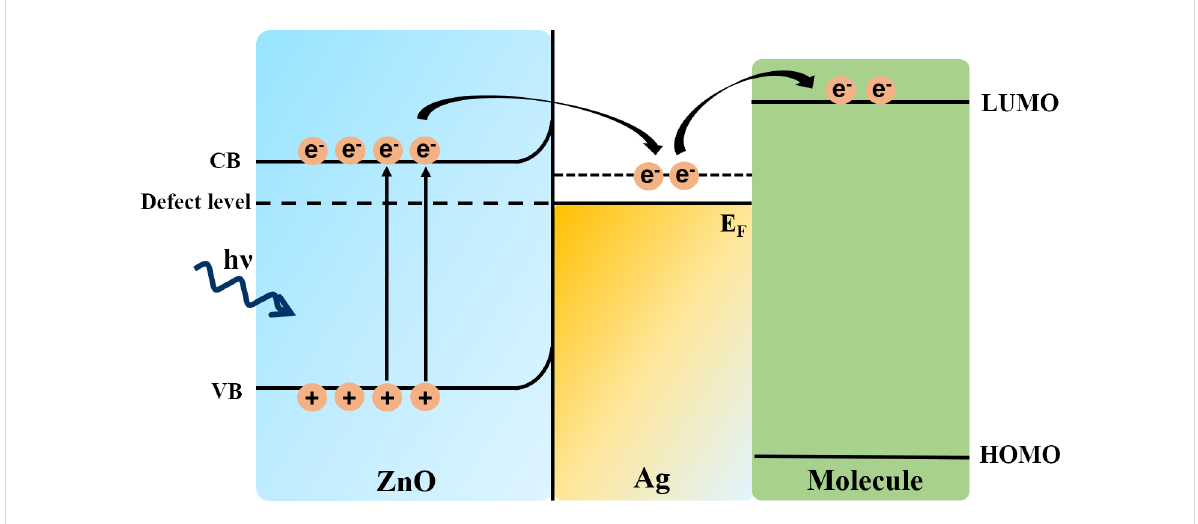
Figure 4: Schematic illustration of the charge transfer mechanism between ZnO, Ag, and the analyte molecule. VB: valence band, CB: conduction band, E F : Fermi level, HOMO: highest occupied molecular orbital, and LUMO: lowest unoccupied molecular orbital.